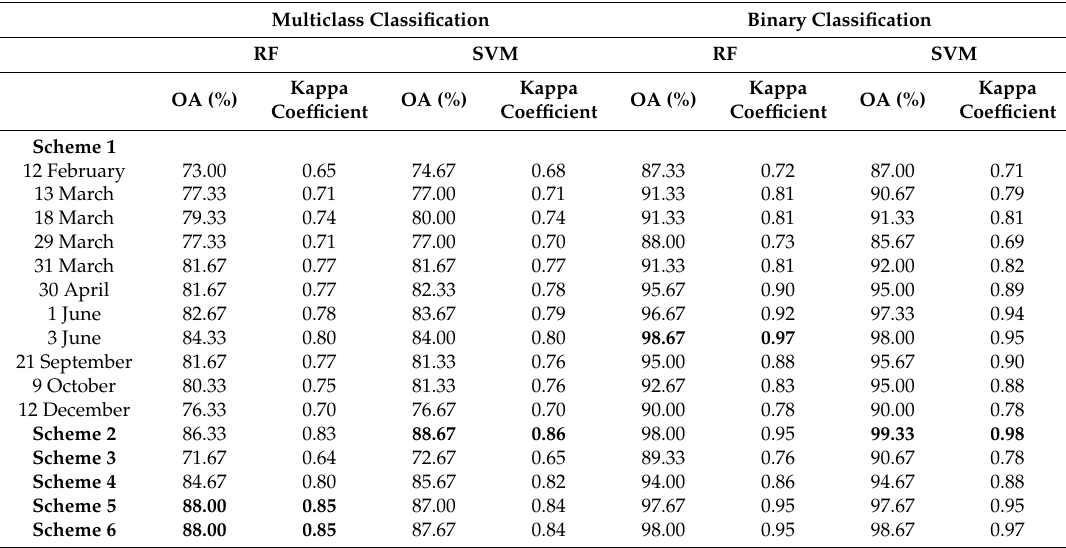
Table 5. Summary of classification accuracies (%) at site B. The highest accuracy identified by model and classification type (i.e., multiclass vs. binary) is shown in bold.